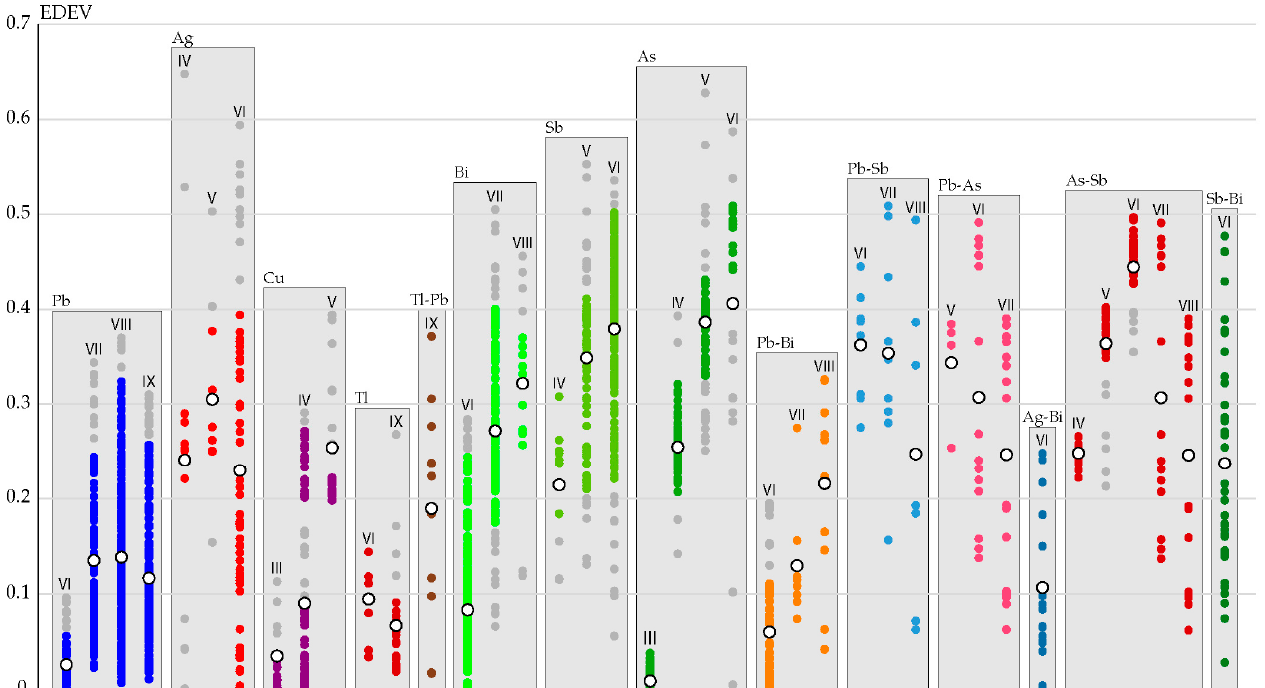
Figure 12. Ranges and average values of EDEV X for a selection of CP in over 170 sulfosalt crystal structures. Roman numerals denote the CN determined by non-zero bond weights of the central atoms indicated at the top of the grey rectangles. Binary mixed central positions for which sufficient data were available are also given. Colored clusters denote ‘significant’ groups accounting for at least 80% of the entire sets of values (applies to polyhedra with sufficient data). Grey circles are singular or less frequent values and describe the overall limits for each type of central atom and CN . White circles are average values.